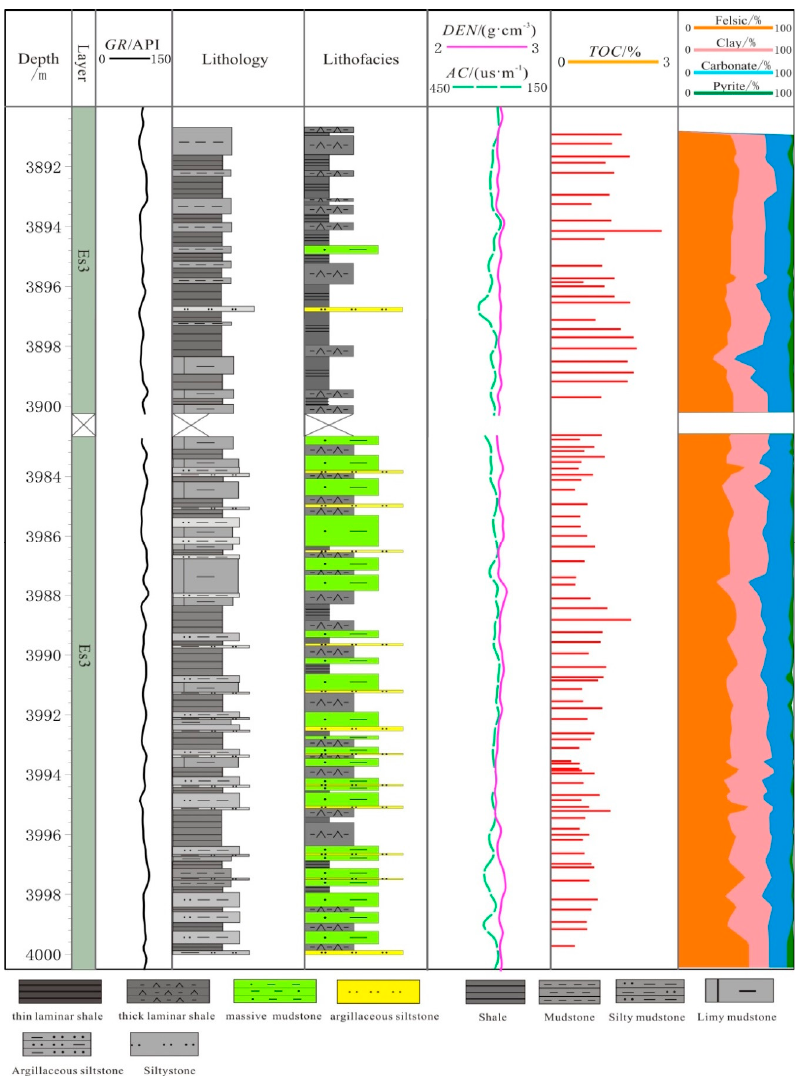
Figure 8. Comprehensive histogram of lithology and lithofacies distribution of upper Es3 coring section in F39x1.